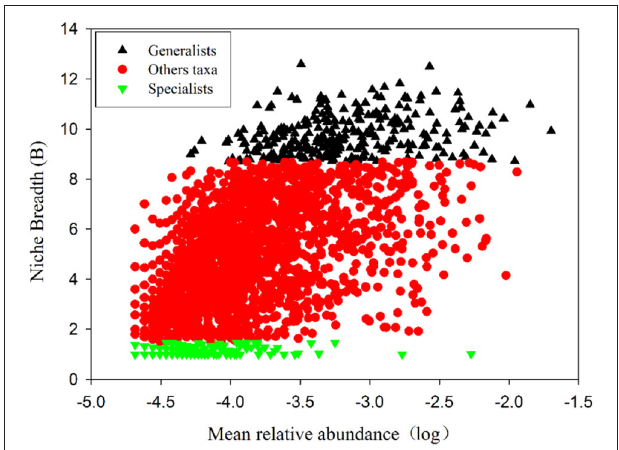
FIGURE 3 | Habitat specialists and generalists on the northern slope of Mount Wutai. Each dot represents an OTU. The x axis indicates mean relative abundances and the y axis indicates Niche Breadth (B). Generalists (black; B > 8.7), Specialists (green; B < 1.5) and Other taxa (red;1.5 ≤ B ≤ 8.7) OTUs are indicated.